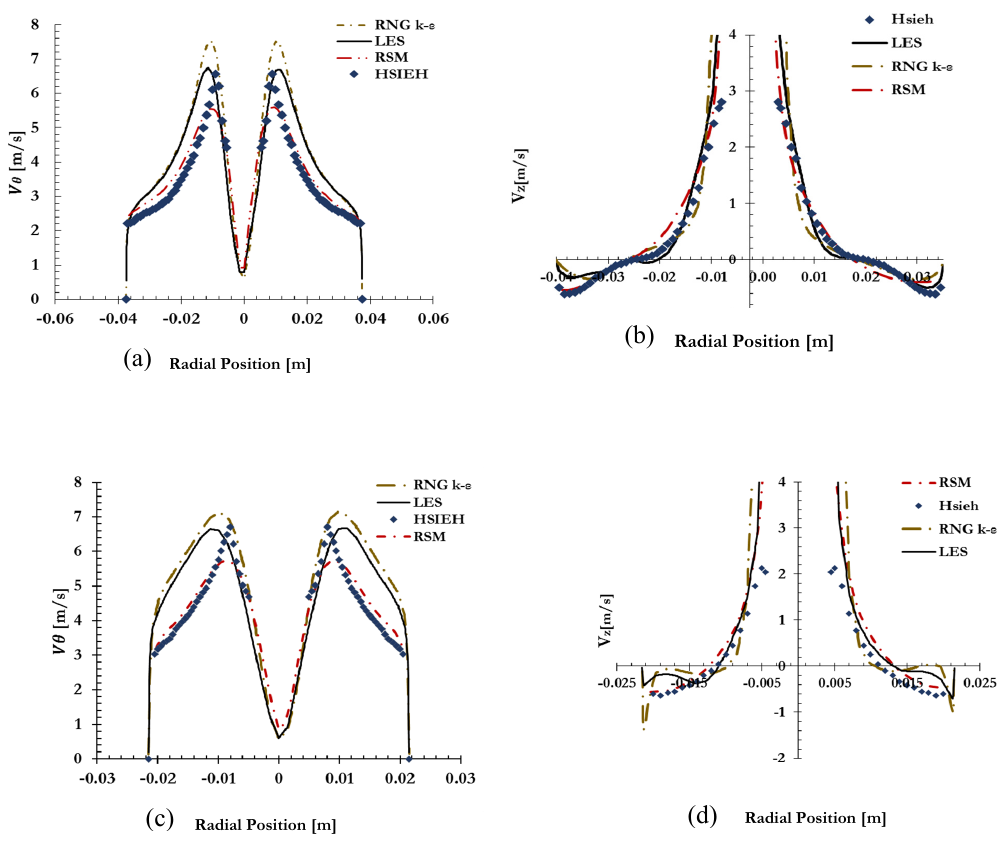
Figure 5. Axial and tangential velocity profile at 60 mm and 120 mm from the top. ( a ) Tangential velocity at 60 mm, ( b ) axial velocity at 60 mm, ( c ) tangential velocity at 170 mm, and ( d ) axial velocity at 170 mm.